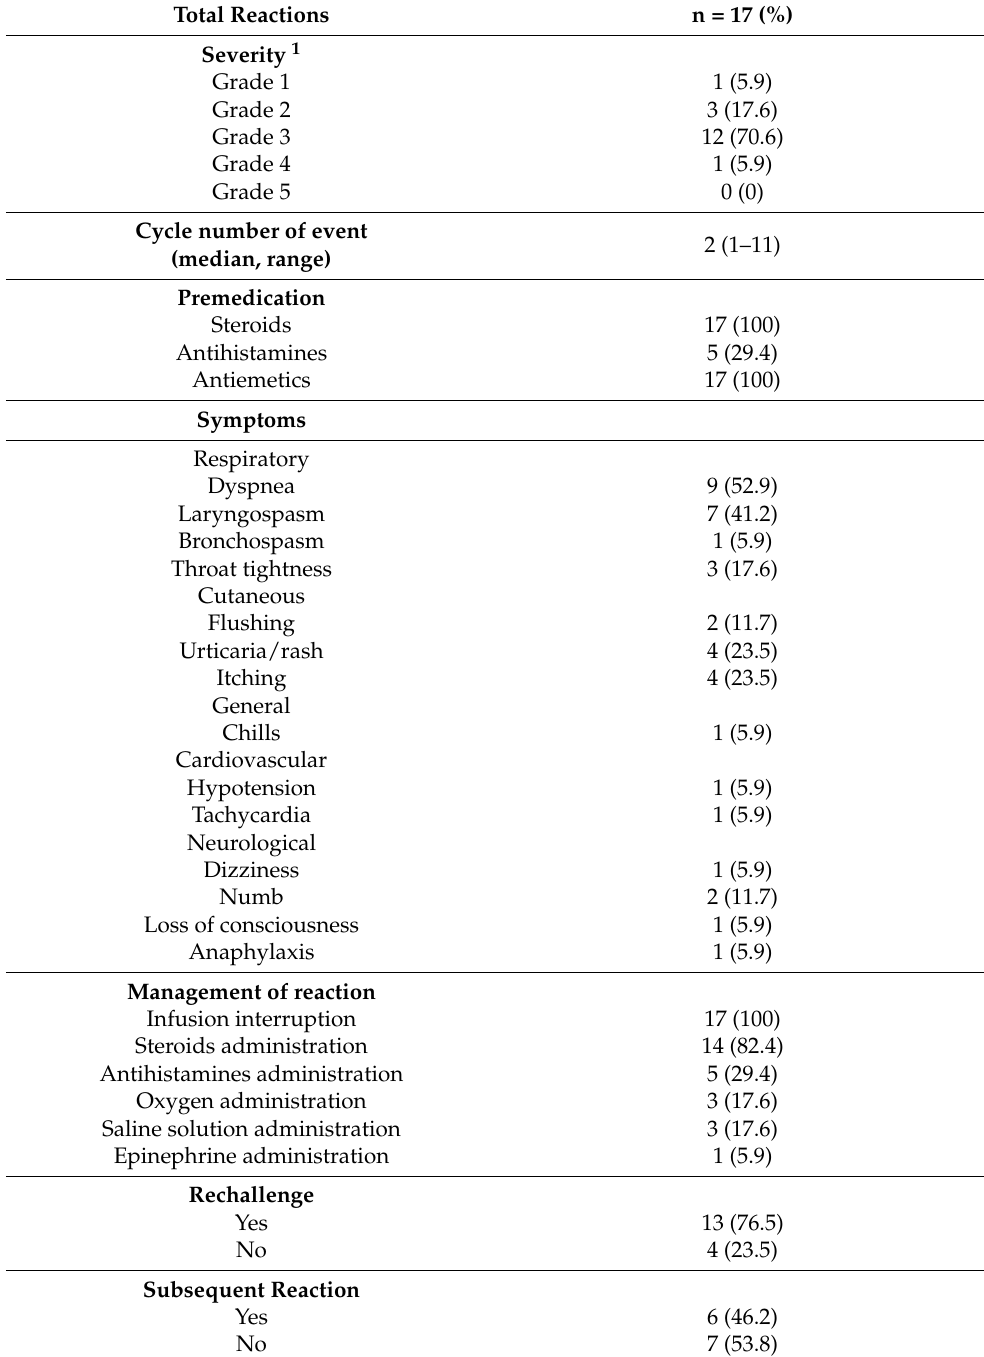
Table 2. Hypersensitivity reactions reported in the study